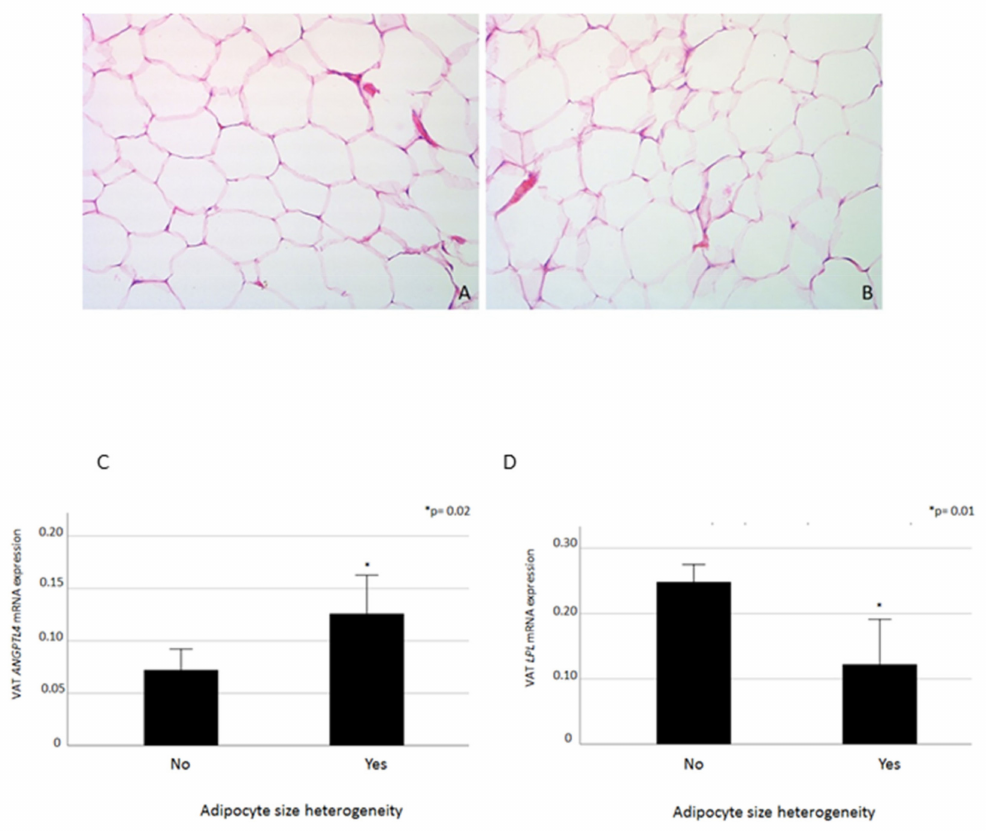
Figure 4. In the upper panel, two representative study participants with homogeneous ( A ) or heterogeneous ( B ) adipocyte size (400 × magnification). In the bottom panel, VAT ANGPTL4 ( C ) and LPL ( D ) mRNA expression levels in relation to the detection of adipocyte size heterogeneity at the immunohistochemistry. Data are expressed as mean ± standard error. * p Value ≤ 0.05 is considered statistically significant.